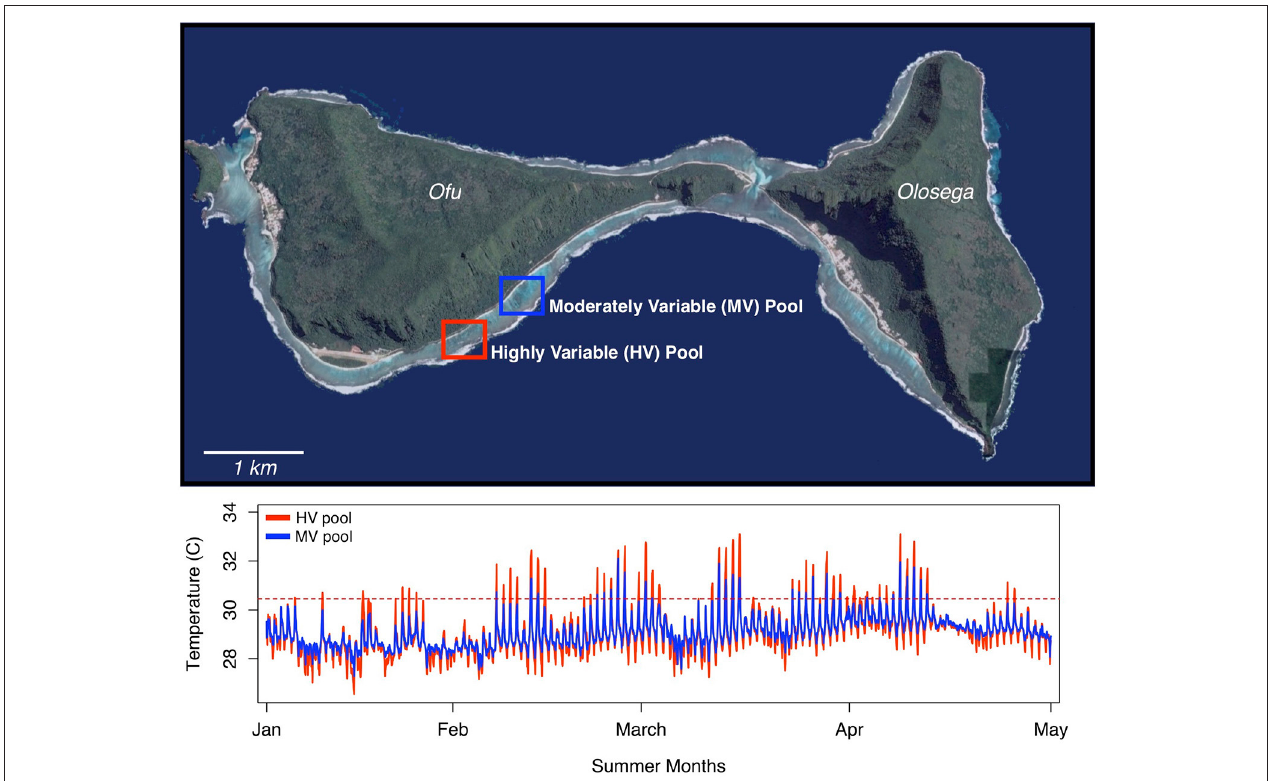
FIGURE 1 | Location of the highly variable (HV) and moderately variable (MV) pools on Ofu, in the Manu’a Islands Group of American Samoa. The plot below shows the temperature profiles over the summer months for the two adjacent back-reef